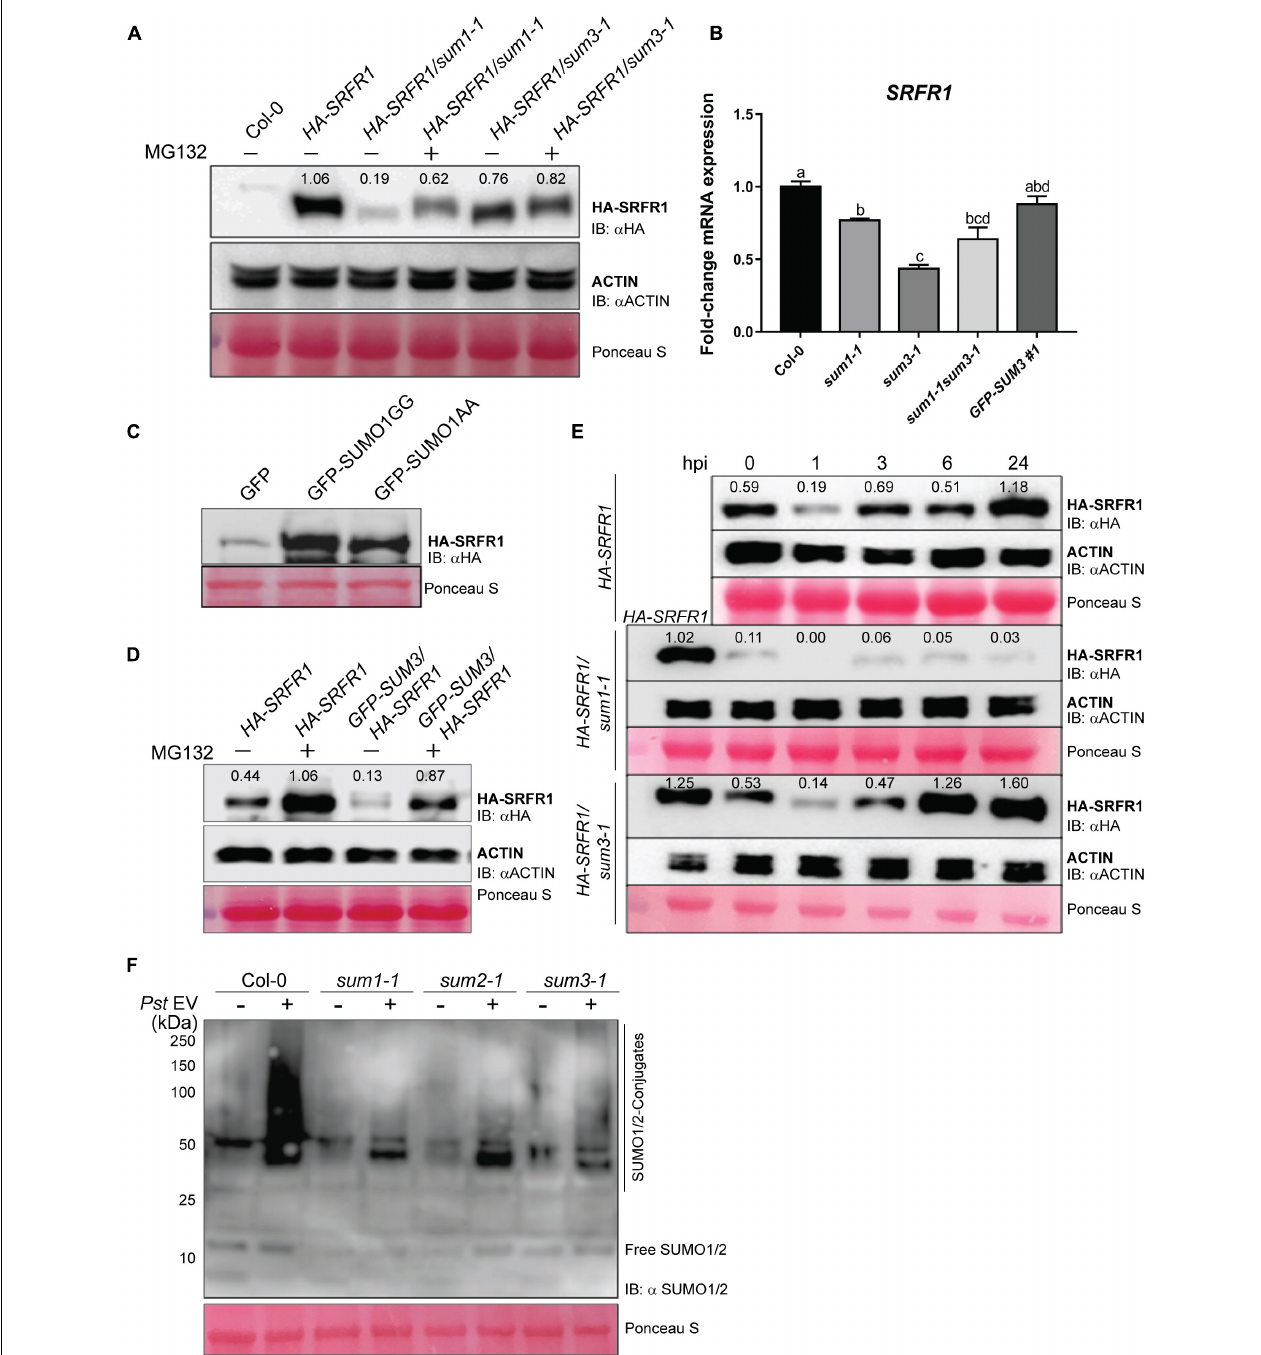
FIGURE 5 | Steady-state levels of SRFR1 are lower in sum1-1 or sum3-1 plants. (A) HA-SRFR1 protein detection in Col-0 (negative control), wild-type ( HA-SRFR1 ), HA-SRFR1/sum1-1 , and HA-SRFR1/sum3-1 plants. (B) Relative abundance of SRFR1 transcripts in Col-0, sum1-1 , sum3-1 , sum1-1 sum3-1 , or GFP-SUM3 overexpressing plants. MON1 expressions were used as the internal control, and values are mean ± SD ( n = 3). Statistical significance is according to post hoc Tukey’s test ( p < 0.05) and represented by different alphabets. HA-SRFR1 protein levels with overexpressed (C) GFP alone, or GFP-SUMO1 GG or AA forms. (D) GFP-SUMO3. (E) Changes in HA-SRFR1 protein at 0, 1, 3, 6, and 24 hpi PstDC3000 ( Pst EV) infection (hpi) in wild-type ( HA-SRFR1 ), HA-SRFR1/sum1-1 , or HA-SRFR1/sum3-1 plants. (F) Accumulation of SUMO1/2-conjugates in Col-0, sum1-1 , sum2-1 , or sum3-1 at 24 hpi. Immunoblots were probed with anti-HA or anti-SUMO1 antibodies as mentioned. Ponceau S staining show protein loadings. Migration position of molecular weight standards (in kDa) is indicated. MG132 treatments, where indicated, was performed at 12 h prior to respective analysis. Numbers above the HA-SRFR1 bands are densitometric quantification values relative to actin expression levels in the same